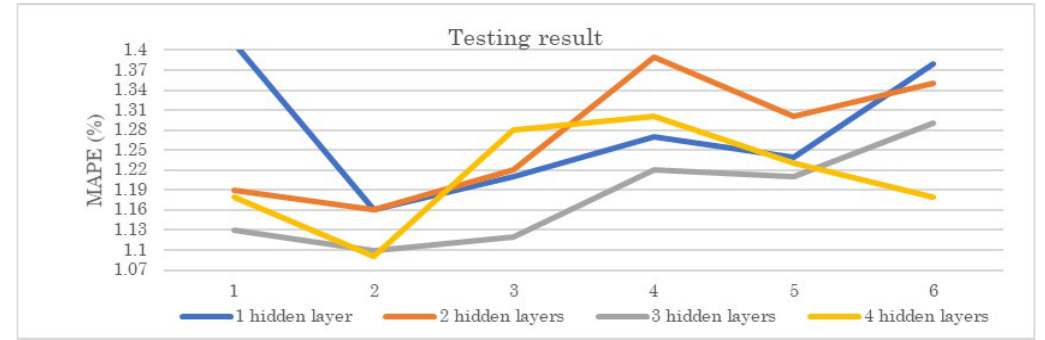
Figure 7. MAPE with different structure of LSTM